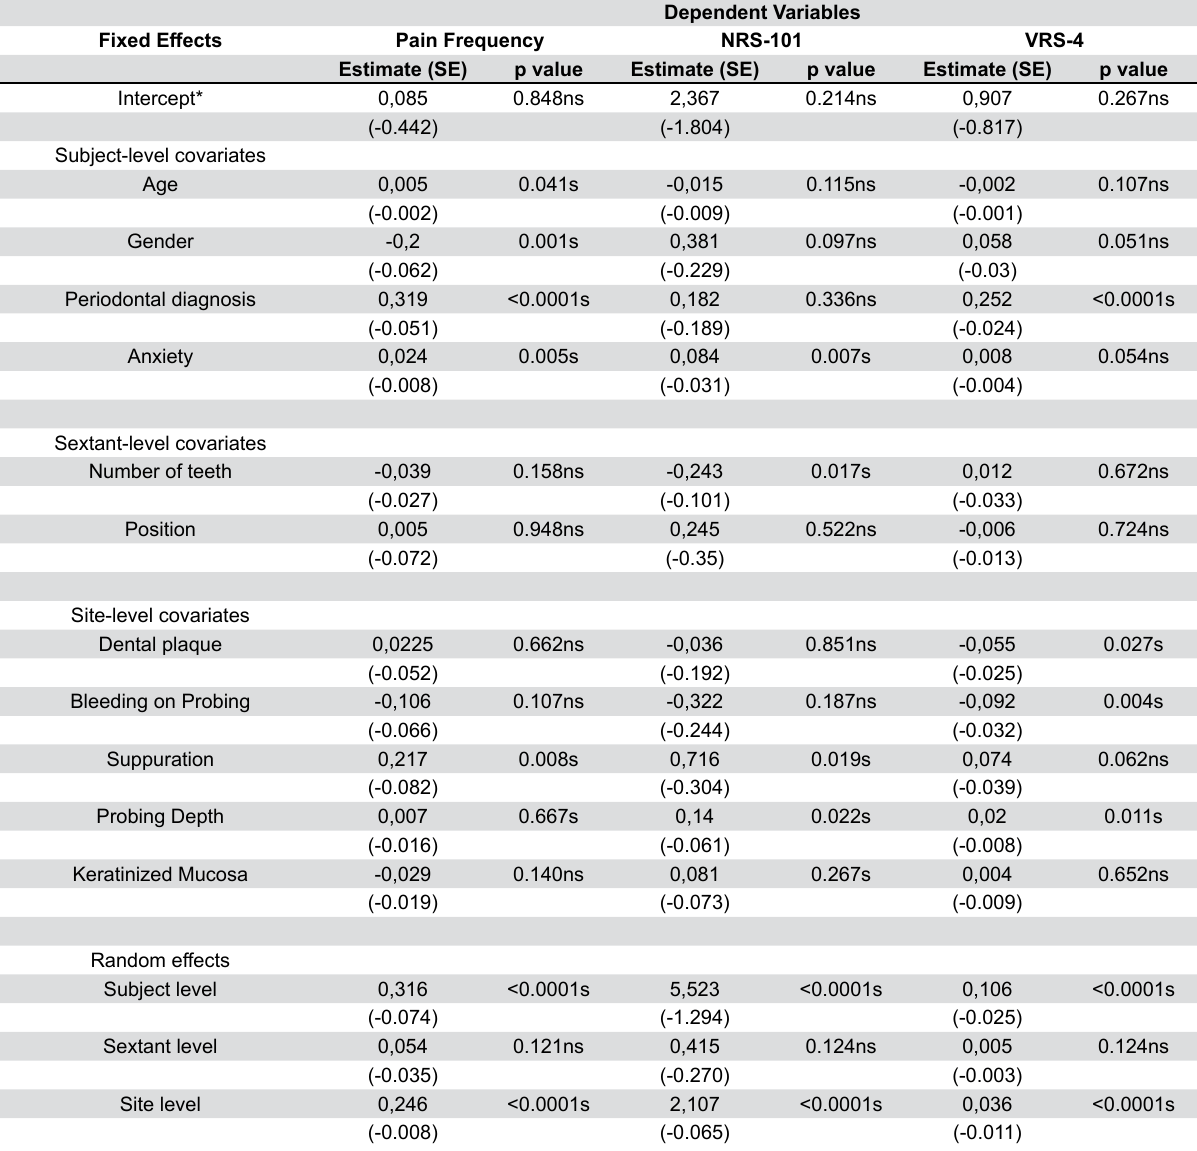
Table 2- Three-level random intercept model for the outcome variable of pain during scaling and root planing using the restricted maximum likelihood estimation